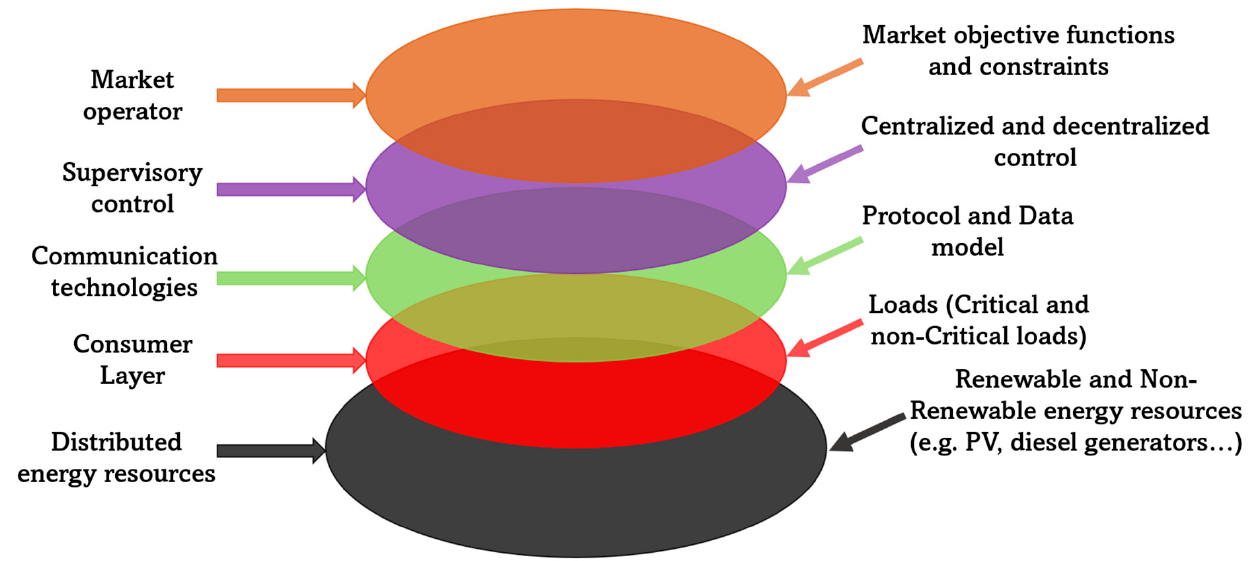
Figure 3. Microgrid architecture model.